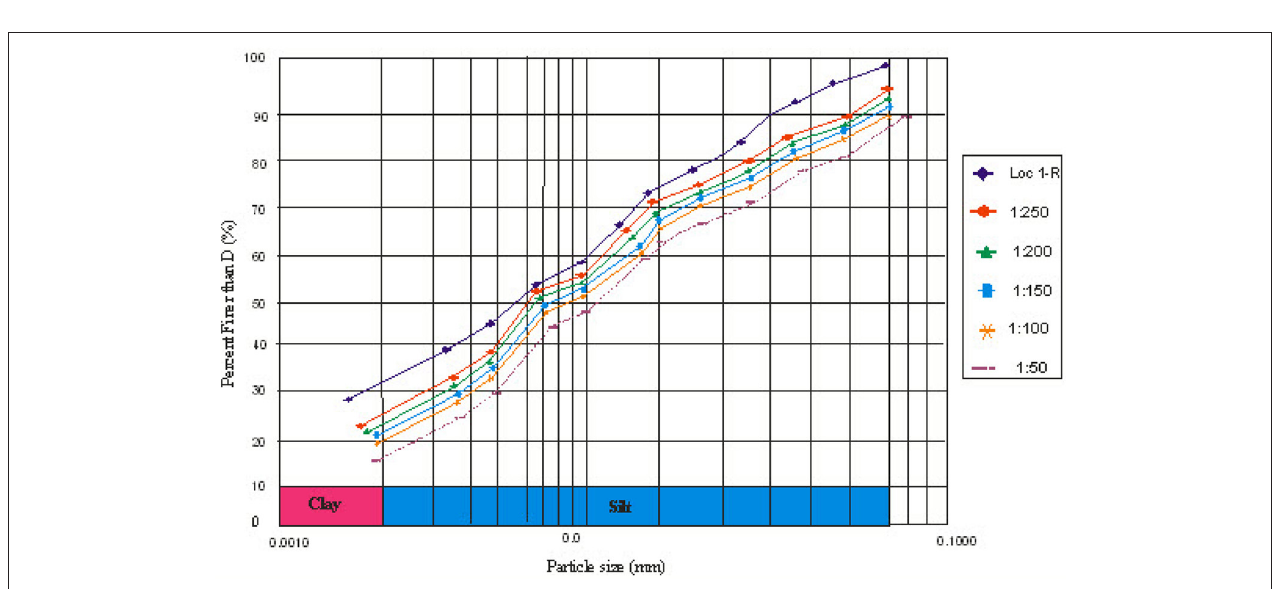
FIGURE 4 | Grain size distribution curves of treated